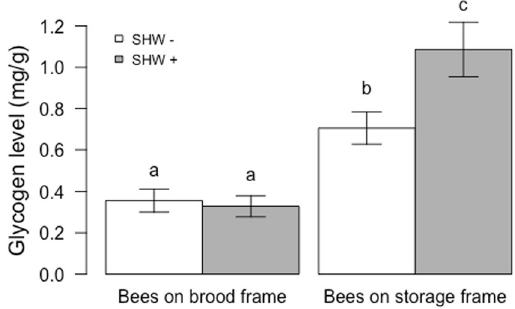
Figure 5. Glycogen levels in whole bees according to the SHW treatments. Mean and standard error of glycogen levels (mg/g) in bees sampled at the end of an SHW − (white bars) or SHW + period (grey bars) (n = 53–54 bees per conditions). The glycogen level was higher in bees sampled on storage frames than on brood frames (P < 0.001) and increased with SHW for bees sampled on storage frames (P = 0.007). Different letters indicate significant differences (ANOVA followed by Tukey’s post hoc comparisons).